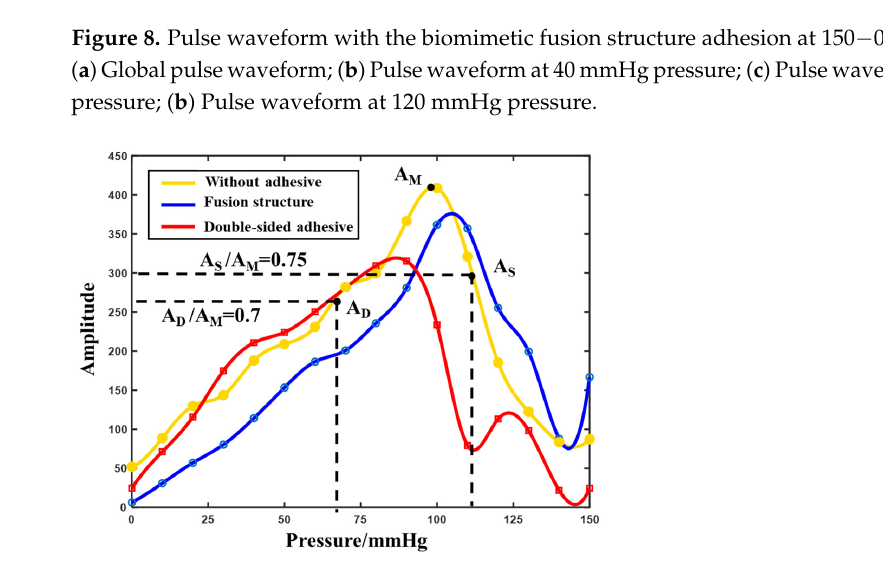
Figure 9. Diagram of blood pressure measurement by the oscillographic method under three attach- ment